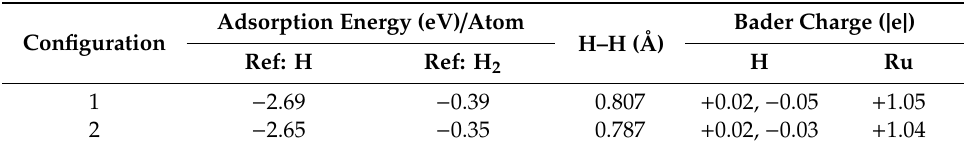
Table 7. Calculated adsorption energies with respect to gas phase molecular hydrogen, H–H bond distances and Bader charges on the Ru and H atoms.